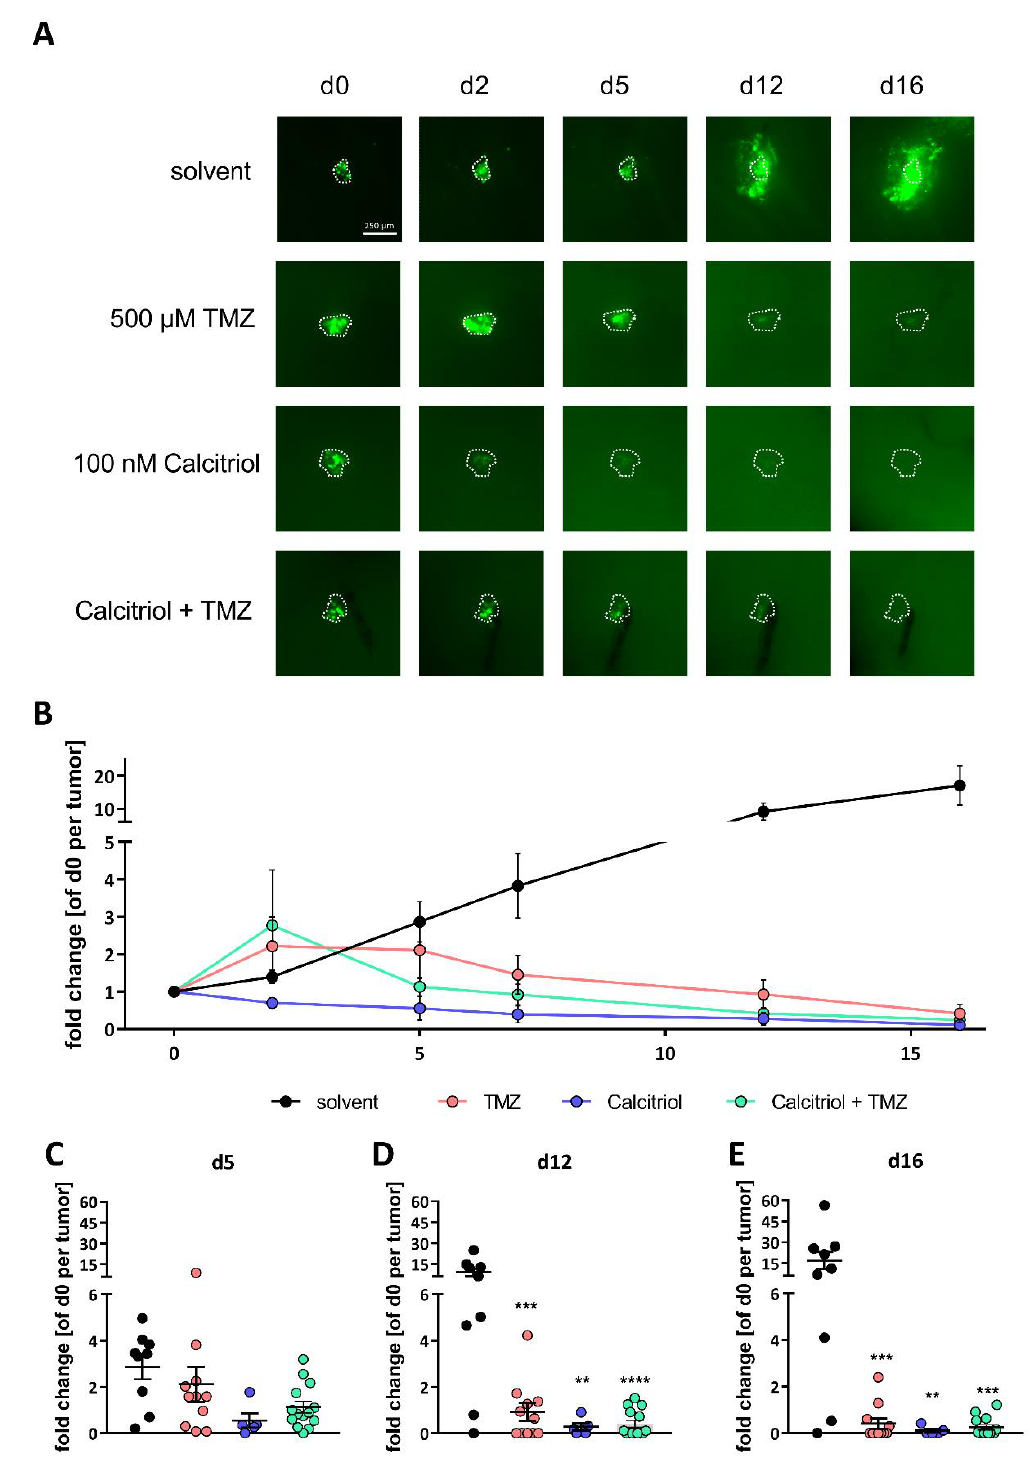
Figure 9. Calcitriol and TMZ prevent tumor growth in ex vivo organotypic tissue culture tumor growth kinetics: ( A ) representative microphotographs of NCH421k GFP + tumors transplanted onto adult murine brain organotypic tissue culture slices after treatment with solvent (DMSO for TMZ; EtOH for calcitriol), 500 µ M of TMZ, 100 nM of calcitriol (Cal) or a combination of both for the times indicated; scale bar: 250 µ m. ( B ) Growth curves of the NCH421k GFP + tumors normalized to the size of tumor d0 after treatment as in ( A ) depicted as the mean ± SEM. ( C – E ) Point-plot of the data summarized in ( B ) after treatment for ( C ) 5 days, ( D ), 12 days and ( E ) 16 days, as in ( A ). * p < 0.05; ** p < 0.01; *** p < 0.001; **** p < 0.0001; two-way ANOVA with Tukey’s multiple comparisons test.